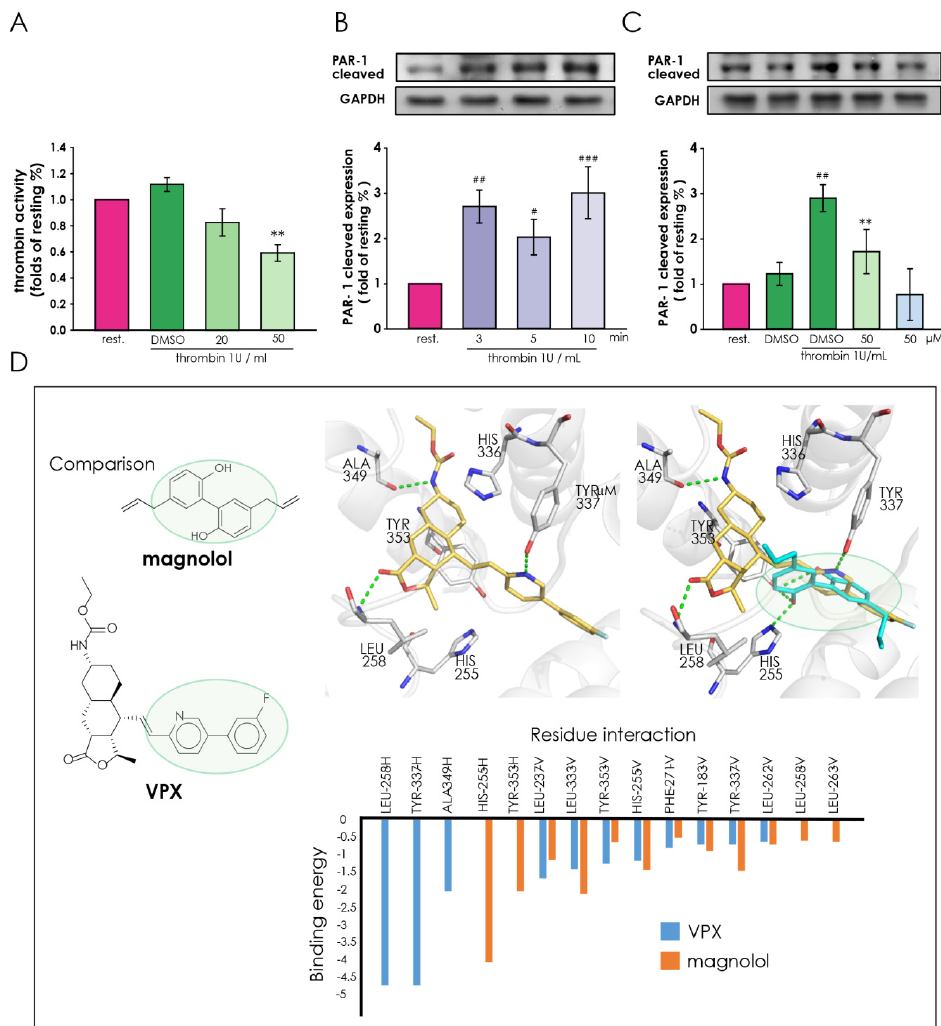
Figure 2. The pivotal role of magnolol in thrombin-mediated protease-activated receptor-1 (PAR-1) activation in A10 cells. ( A ) Thrombin activity was measured by a fluorometric assay kit. ( B ) A10 cells were serum-starved for 6 h and then incubated with thrombin (1 U) for the indicated times (0, 3, 5, 10 min) to evaluate the time course of thrombin-induced cleavage of PAR-1. ( C ) Serum-starved A10 cells were incubated with magnolol (10–50 µ M) or 0.05% DMSO for 90 min and followed by thrombin (1 U/mL) treatment for 3 min. ( B , C ) The cleavage form of PAR-1 was detected through Western blotting under each condition. ( D ) The docking pose of magnolol (top left, blue) in the PAR-1 active site. The docking pose in 2D (top right) highlights both hydrogen and hydrophobic interactions as dotted lines and green lines, respectively. The co-crystal ligand, VPX (bottom, yellow), is superimposed onto magnolol (blue). They contain similar aromatic ring structures that occupy a similar space within the PAR-1 active site (green circle). Green dashed lines denote hydrogen bonds in 3D renderings. Data ( A –C) were presented as the means ± SD (n = 3). ### p < 0.001, ## p < 0.01 and # p < 0.05, compared with the resting group; ** p <0.01, compared with the DMSO plus thrombin treated group.